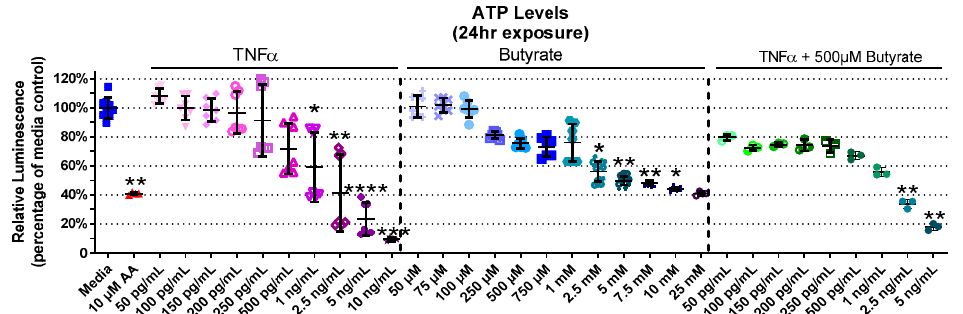
Figure 2. Relative ATP Levels after exposure to butyrate and TNF α for 24 h. Antimycin (AA) was used as a positive control. Relative luminescence is graphed for each experimental group and is normalized to the medium control (horizonal bar represents mean relative fluorescence ± standard deviation). Asterisks indicate degree of significance from medium control (Kruskal–Wallis test fol- lowed by a Dunn’s multiple comparison test relative to the medium control, n = 3–4/experiment; two independent experiments were combined; * = p < 0.05, ** = p < 0.01, *** = p < 0.001, **** = p < 0.0001). Note: for statistical comparisons made amongst all groups, see Supplemental Data Table S3.